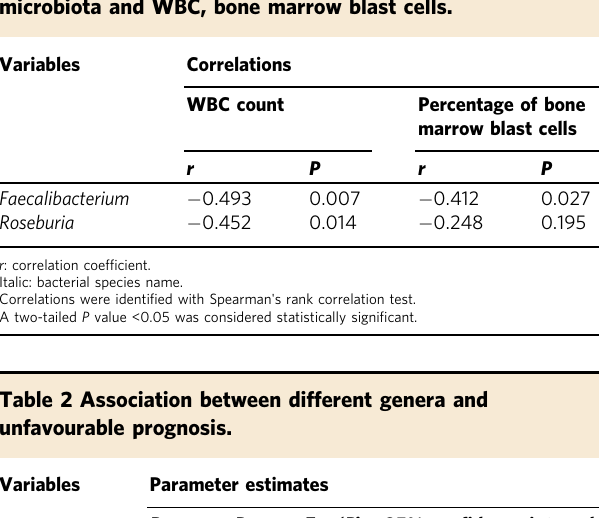
Table 1 Correlation analysis between differential gut microbiota and WBC, bone marrow blast cells.